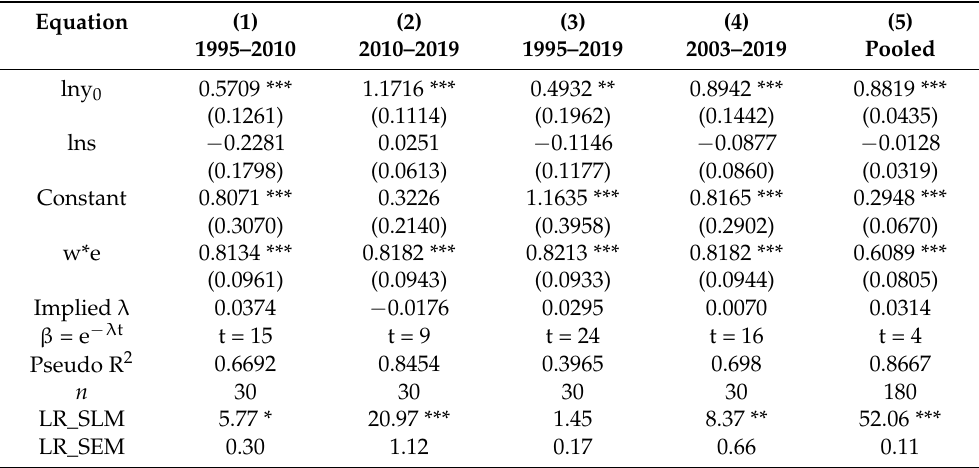
Table 4. Conditional Convergence Test of Spatial Cross-Sectional